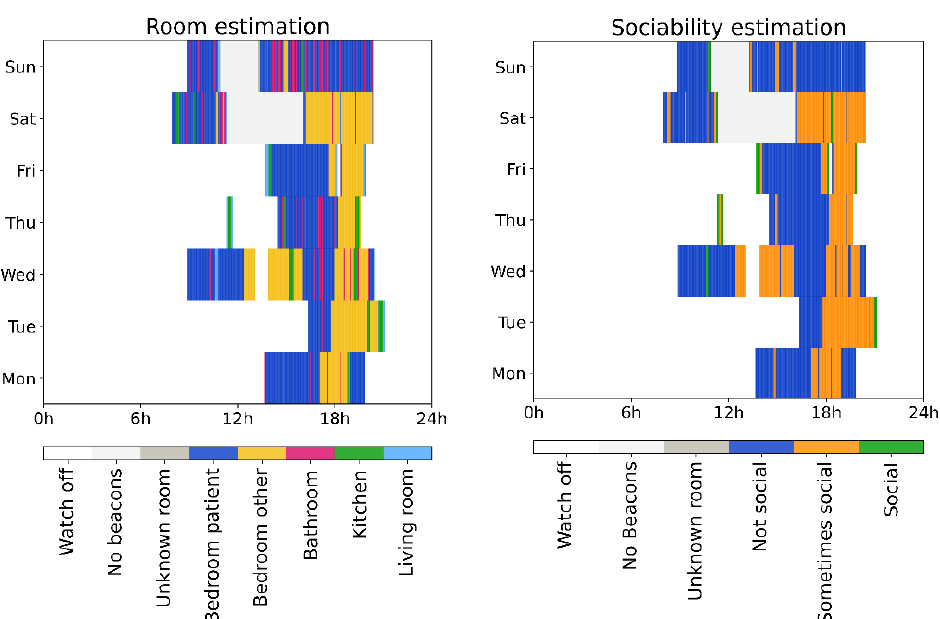
Figure 6. One-week long room ( left ) and sociability ( right ) estimation during the study, from a Monday to Sunday for a different participant with ASD in a different household (hence different rooms and rooms sociability per room compared to Figure 5). ‘Watch off’ indicates that the participant was not wearing the watch; ‘No beacons’ that the participant has no registered beacon in the proximity wearing the watch, maybe outdoors; ‘Unknown room’ that the participant was at home, but the algorithm could not estimate the room the participant was in with confidence.